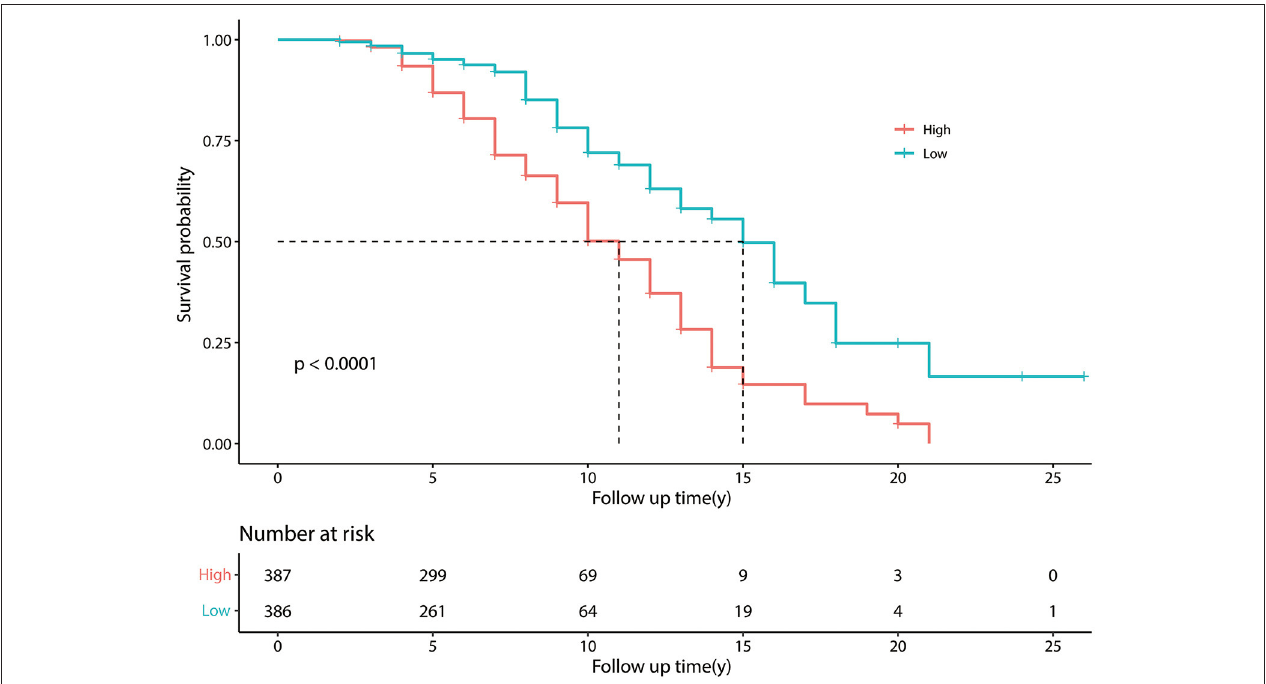
FIGURE 2 | Kaplan–Meier survival curves. Kaplan–Meier curves constructed by the training set, showing that as time went by, there was a significant difference between patients with Parkinson’s disease (PD) with a higher risk of developing freezing of gait (FOG) and patients with a lower risk of developing FOG. The number at risk means the number of patients with PD in the group of higher and lower risk of developing FOG; Follow up time (y) means the time from a patient was diagnosed with PD to the end of the follow-up period, in other words means “disease duration at baseline plus 1